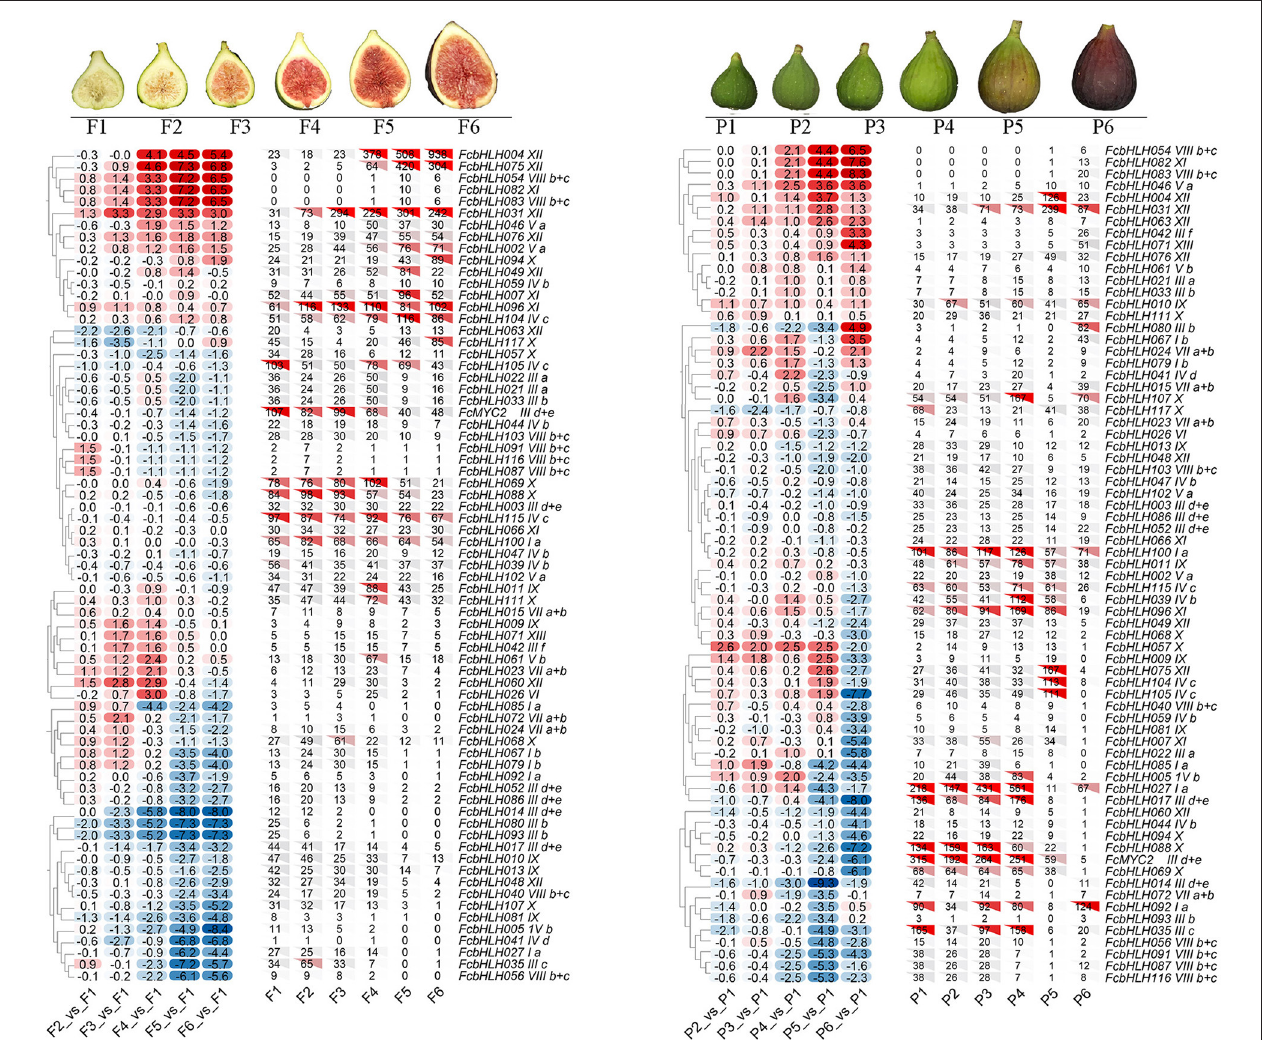
FIGURE 3 | Expression profile of FcbHLH genes in the female flower tissue and peel of fig fruit. Expression of FcbHLH genes is expressed by FPKM value and log 2 FC. Hierarchical clustering method and average linkage method were used to construct the clustering tree. Log 2 FC > 0 indicates upregulation, and log 2 FC < 0 indicates downregulation. F1–F6 and P1–P6 represent the six stages of “Purple-Peel” female flower tissue and peel, respectively, during fig fruit